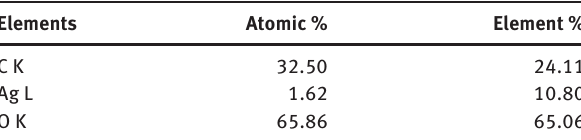
Table 1 Atomic% and element% of Ag-PVA nanocomposite. Elements